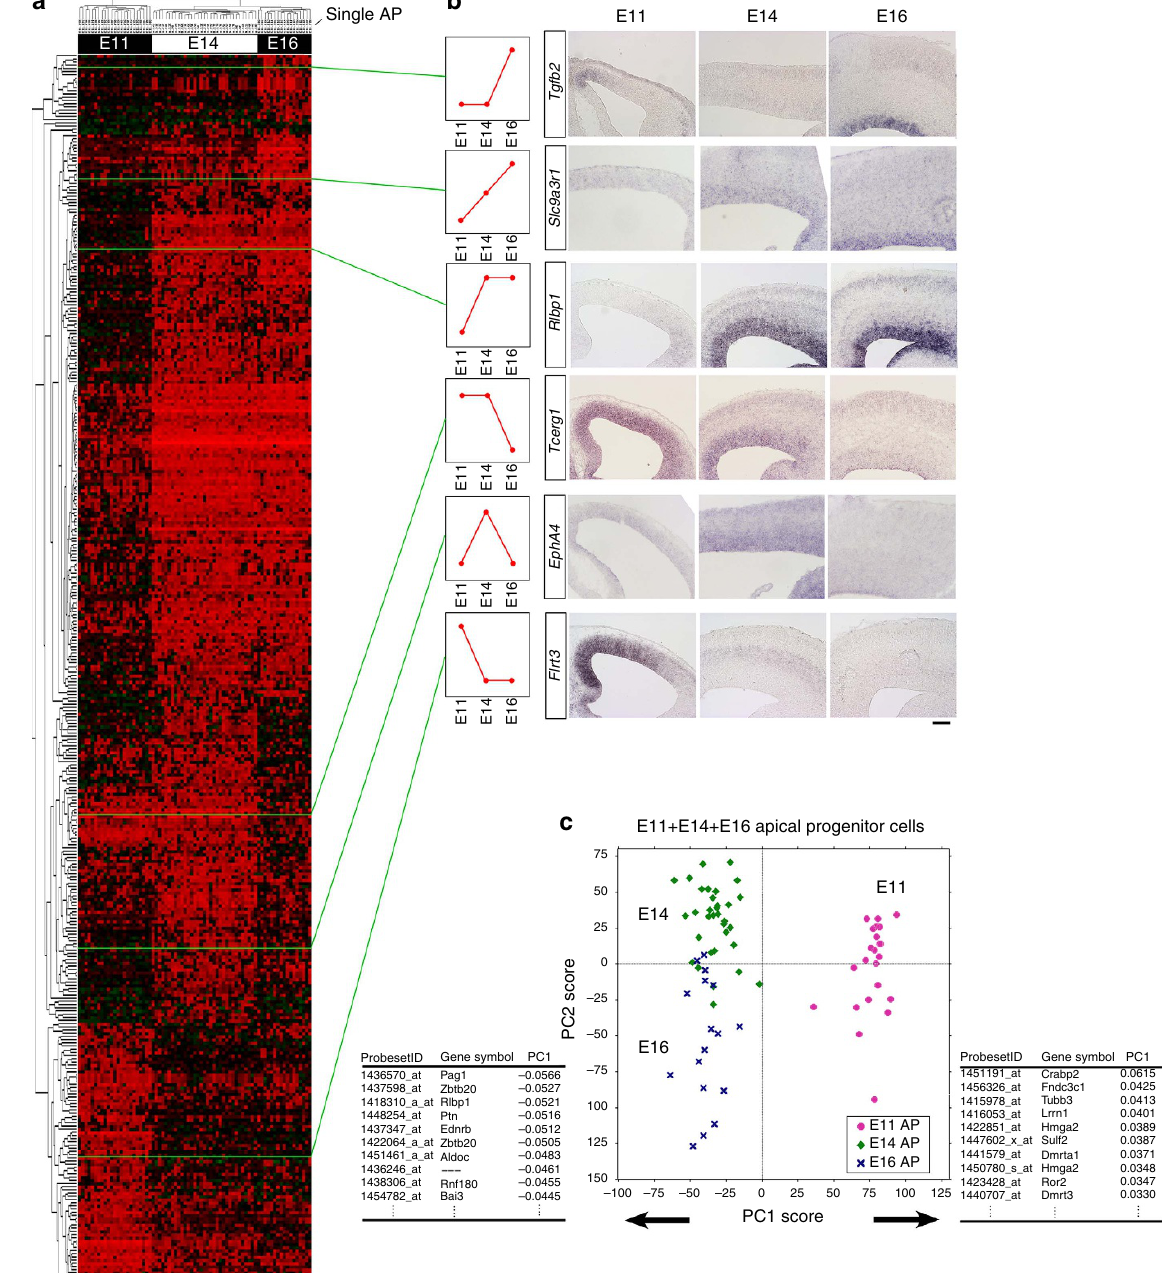
Figure 2 | Temporal change in gene expression in APs. ( a ) Two-way cluster analysis of genes differentially expressed among E11, E14 and E16 single-cell cDNAs of the APs (384 probe sets, Supplementary Data 1, selected by one-way ANOVA). Examples of genes that exhibited typical expression patterns in E11, E14 and E16 cerebrum are shown in b or Supplementary Figs 5 and 6. The ‘medial 4 lateral’ genes exhibited an ‘E11 4 E14’ trend, and the ‘medial o lateral’ genes exhibited an ‘E11 o E14’ trend (Supplementary Fig. 7). Scale Bar, 100 m m ( c ) Global gene-expression patterns of E11 APs are very different from those of E14/E16 APs. PCA was performed on microarray data from single-cell cDNAs of all APs (total N ¼ 73: mixture of E11, N ¼ 23; E14, N ¼ 33; E16, N ¼ 17 single cells; 17192 probe sets). Each symbol indicates one cell. PC1, the most representative axis for the gene-expression variation among the AP population, is determined by the difference between E11 and E14/E16 cells. The lists below indicate the top 10 genes that positively or negatively influence PC1. Proportion of variance: 0.0436 (PC1) and 0.0319 (PC2). See also Supplementary Figs 5–9 and Supplementary Data